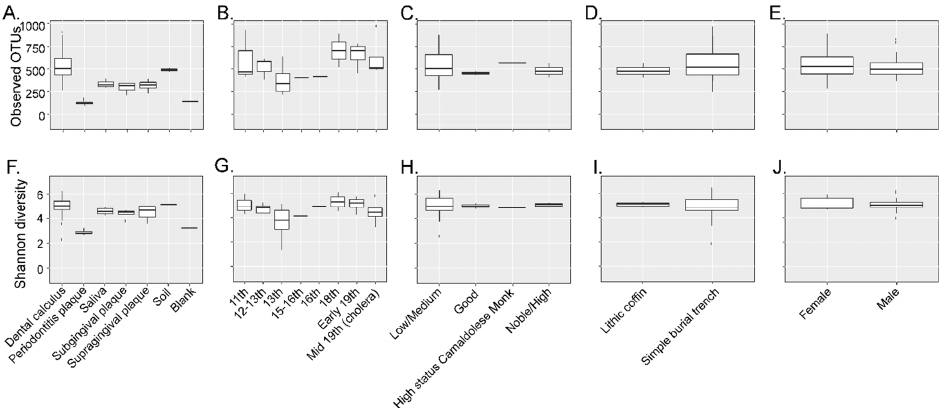
Figure 3. The α -diversity analyses. Observed OTUs were determined for the dental calculus samples based on sample type ( Panel A ), century ( Panel B ), social status ( Panel C ), burial type ( Panel D ), and gender ( Panel E ). Shannon diversity was determined based on sample type ( Panel F ), century ( Panel G ), social status ( Panel H ), burial type ( Panel I ), and gender ( Panel J ). Furthermore, β -diversity based on the Bray–Curtis distances was visualized as PCoA plots.